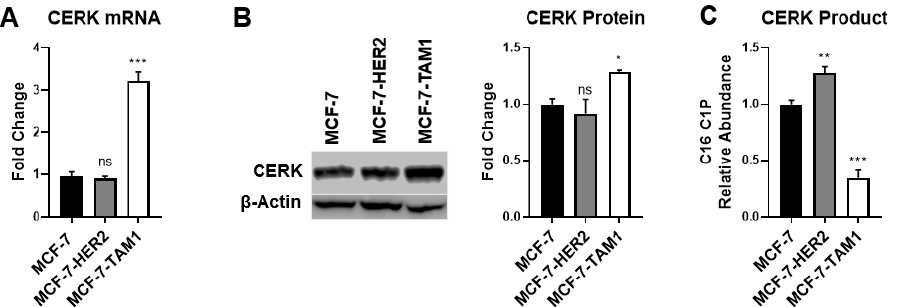
Figure 3. Tamoxifen-resistant cells do not have different CERK expression and/or product levels. ( A ) Total RNA was extracted and CERK mRNA was measured from MCF-7, MCF-7-HER2, and MCF-7-TAM1 cells by RT-qPCR. Fold change for CERK mRNA was calculated relative to CERK expression in MCF-7 cells. ( B ) Total protein was extracted and CERK protein levels were measured by Western blot. CERK protein expression was normalized to β -actin and was quantified as fold change relative to normalized CERK protein expression in MCF-7 cells. The uncropped Western blots have been shown in Figure S4. ( C ) C16-C1P level was measured in three cell lines by LC-MS/MS and relative levels of C16-C1P in the tamoxifen-resistant cell lines were quantified as fold changes relative to the C16-C1P level in MCF-7 cells. ns: not significant, * p < 0.05, ** p < 0.01, *** p <